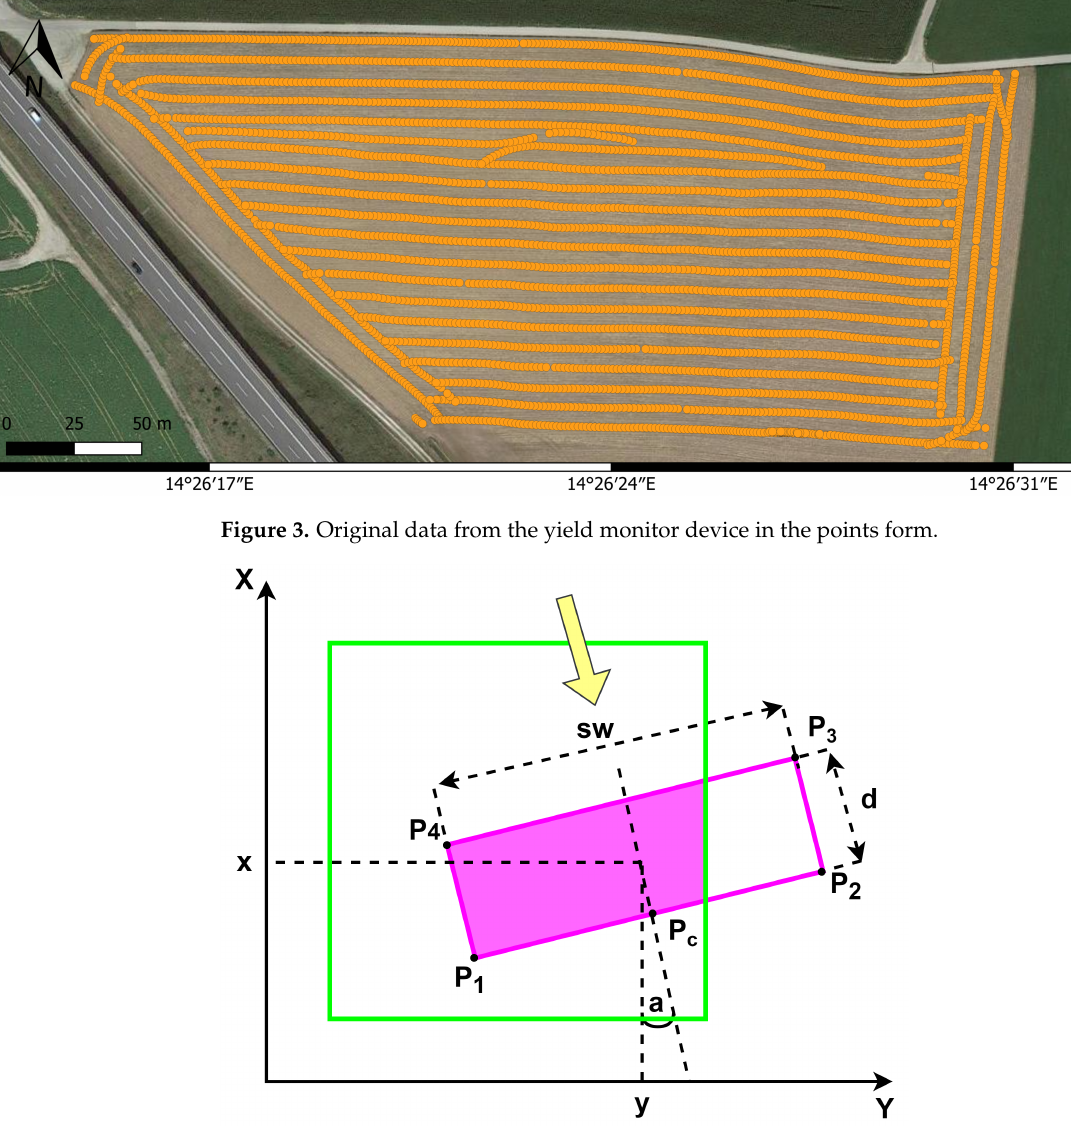
Figure 4. Graphic representation of polygon and pixel overlap for PPI